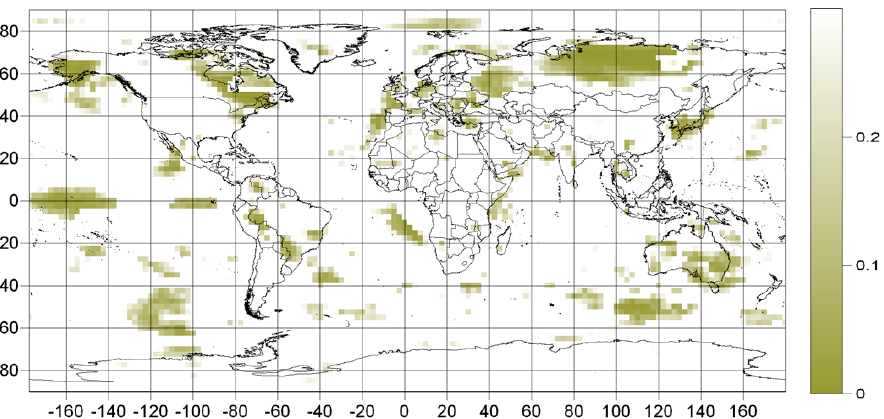
Fig. 1. The probability values associated with the cycle of 30months (see Sect. 2.2). The cycles observed in a zone corresponding to the colour white are not significant.